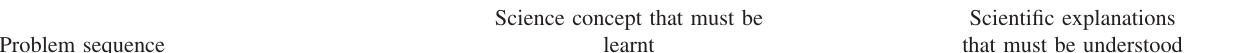
TABLE I. Problem based structure of the sequence on “How are bodies charged? How can we charge them more efficiently?” Science concept that must be Problem sequence